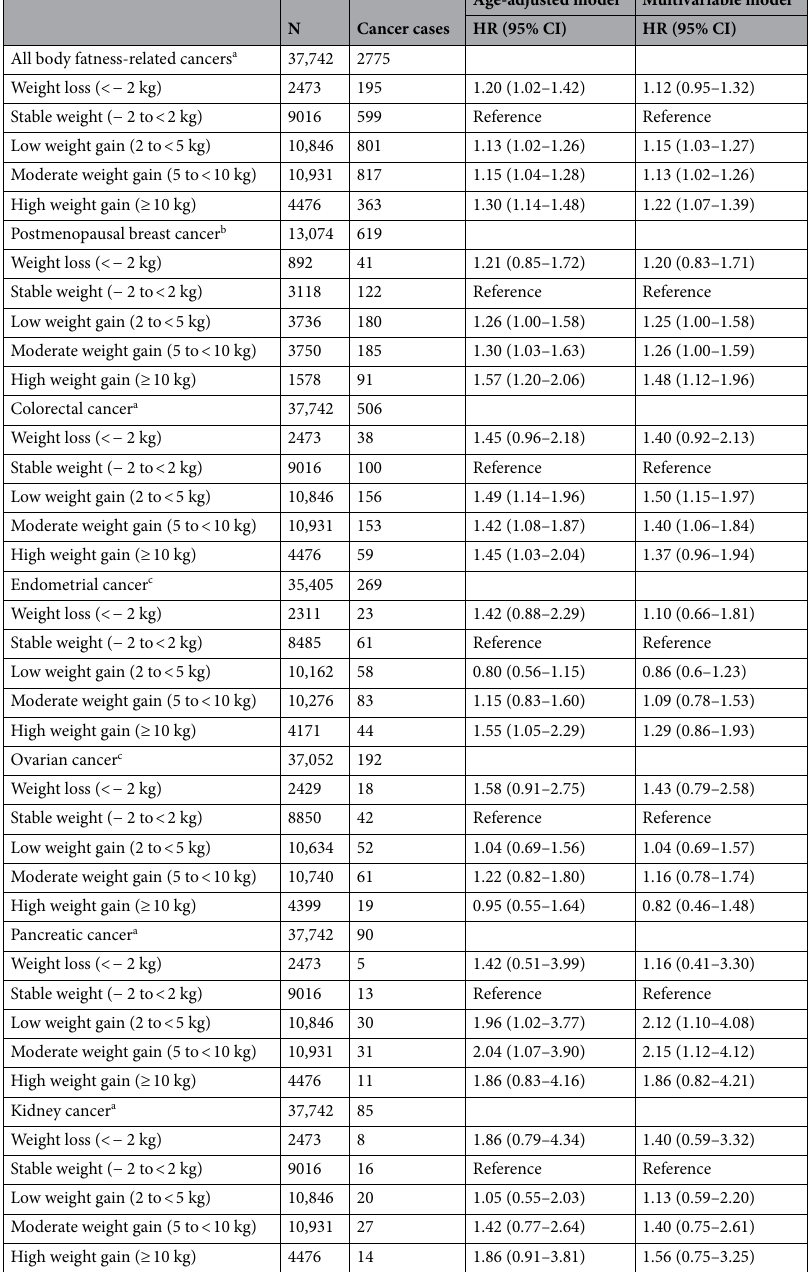
Table 2. Weight change and risk of body fatness-related cancer. HR hazard ratio, CI confidence interval. a The multivariable model for all body fatness-related cancers, colorectal, pancreatic and kidney cancer included the variables; weight, age, alcohol intake, education, physical activity level, physical activity level change, smoking status, smoking status change. In the colorectal cancer models the first four years of follow-up are excluded. b The multivariable model for postmenopausal cancer were only in women who were postmenopausal at the second questionnaire and included the variables; weight, age, age at menarche, alcohol intake, education, physical activity level, physical activity level change, smoking status, smoking status change. c The multivariable model for endometrial and ovarian cancer included the variables; weight, age, age at menarche, alcohol intake, education, menopausal status, physical activity level, physical activity level change, smoking status, smoking status